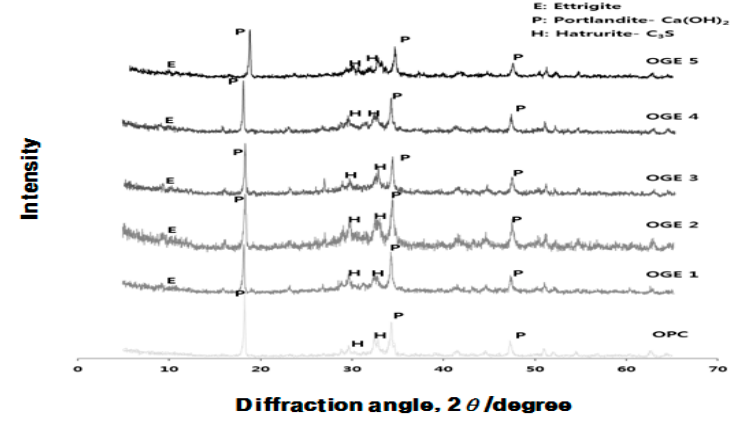
Figure 13. Quantitative analysis on the crystal structure of OGE by aging time at different ESA burning temperatures (3rd day).